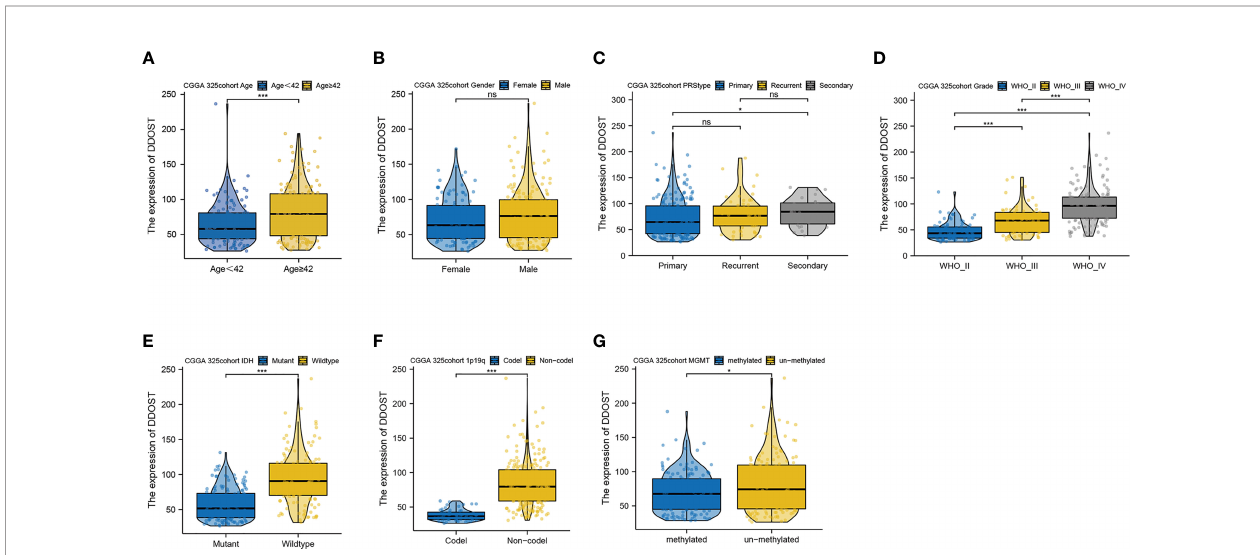
FIGURE 3 | Expression difference of DDOST between different clinical characters in patients with glioma in the CGGA 325 cohort. The expression of DDOST in different age (A) , gender (B) , PRS type (C) , grade (D) , IDH (E) , 1p19q (F) , and MGMT status (G) . * p < 0.05, *** p < 0.001. ns, not signi fi